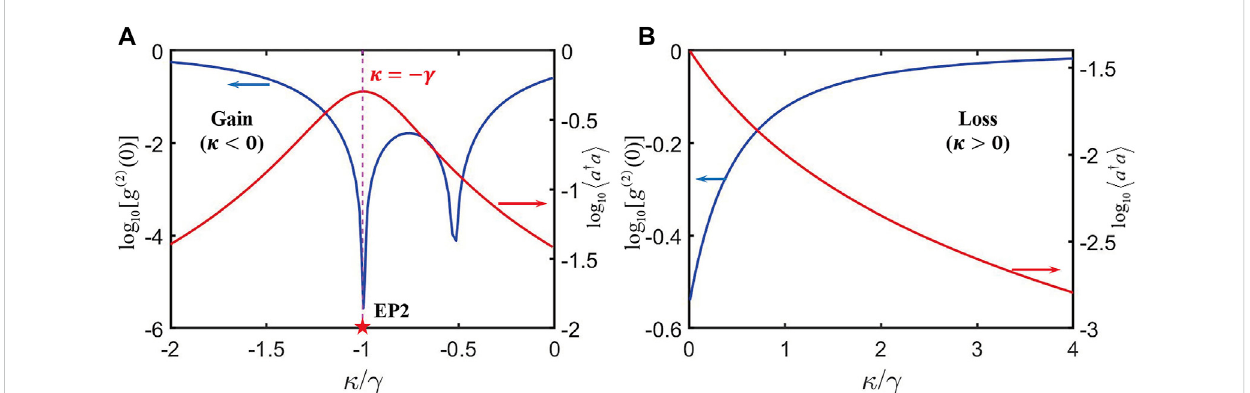
FIGURE 5 Second-ordercorrelationfunction g ( 2 ) ( 0 ) andthemeanphotonnumber I c asfunctionsof κ inthesystemwiththegaincavity(Panel (A) )andwiththe loss cavity (Panel (B) ). Here, we take the coupling regime at g (cid:1) g EP 2 (cid:1) 1